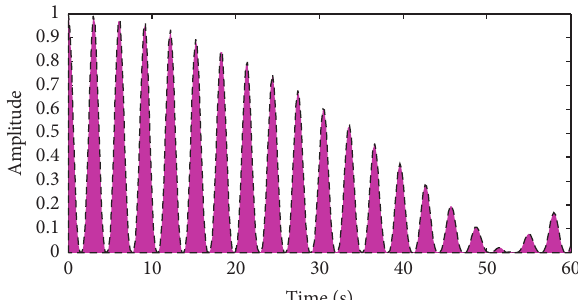
Figure 7: Time-domain waveform of pure